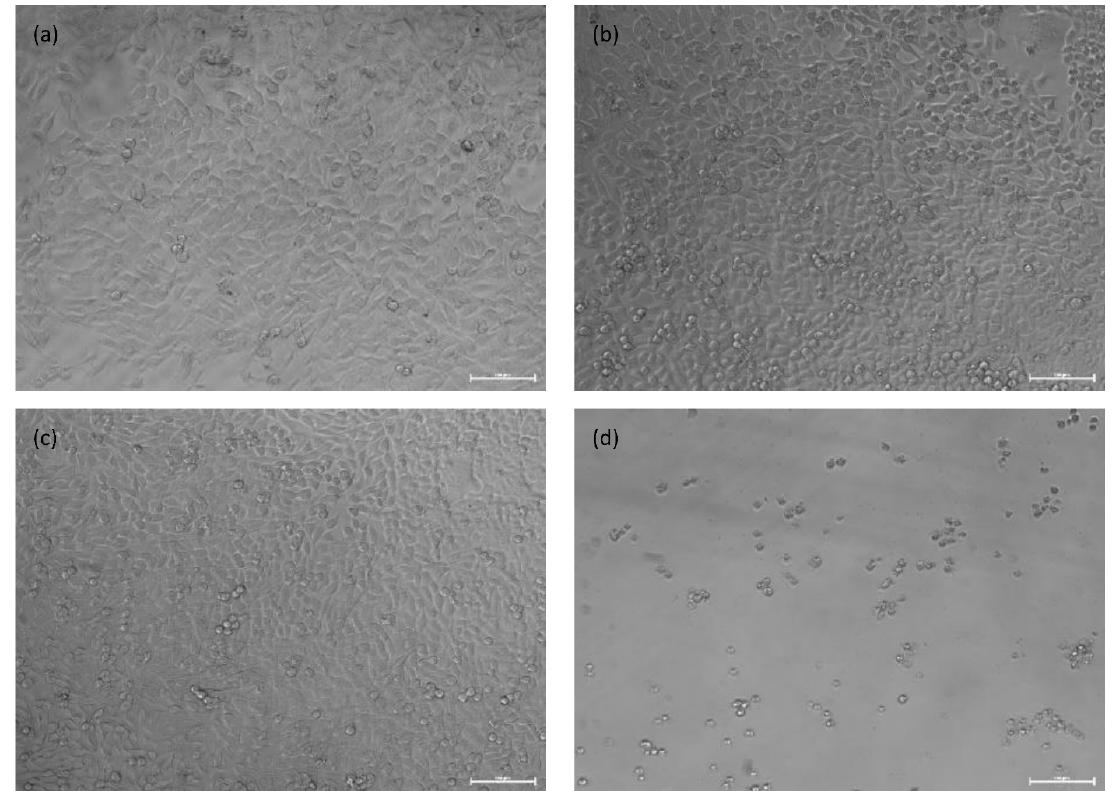
Figure 14. General appearance of 4T1 cells after 48 h incubation in extracts of: ( a ) Ti–6Al–4V alloy, ( b ) 10% OI–TiZn, ( c ) DMEM, and ( d ) 10% DMSO.